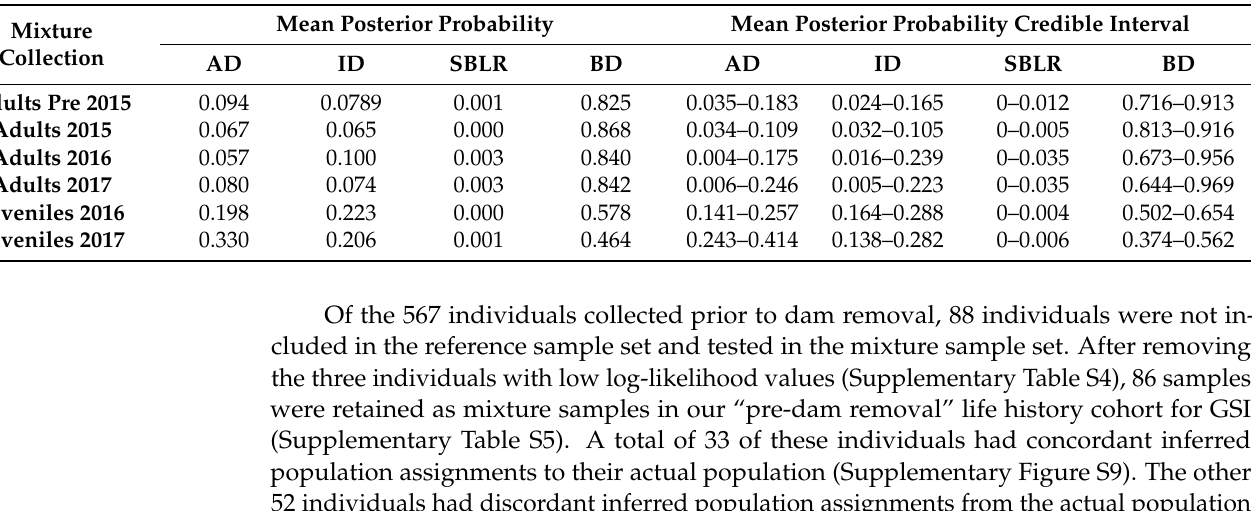
Figure 5. Inferred proportion of genetic ancestry from each of the four reference populations across recolonizing adult steelhead and juvenile smolt life history cohorts. Colors are representative of the inferred population. The bottom x axis divides life history cohorts temporally and the right y axis divides them by life history stage. We included the South Branch of the Little River (SBLR) as a control because we did not expect to see assignment to that population. Table 3. The mean probability of assignment to each population represented in the steelhead life history cohorts sampled post-dam removal varied temporally. The below-dam population represented the largest proportion of genetic ancestry in the first steelhead life history cohorts recolonizing the Elwha River following dam removal with increased representation from above- and in-between-dam